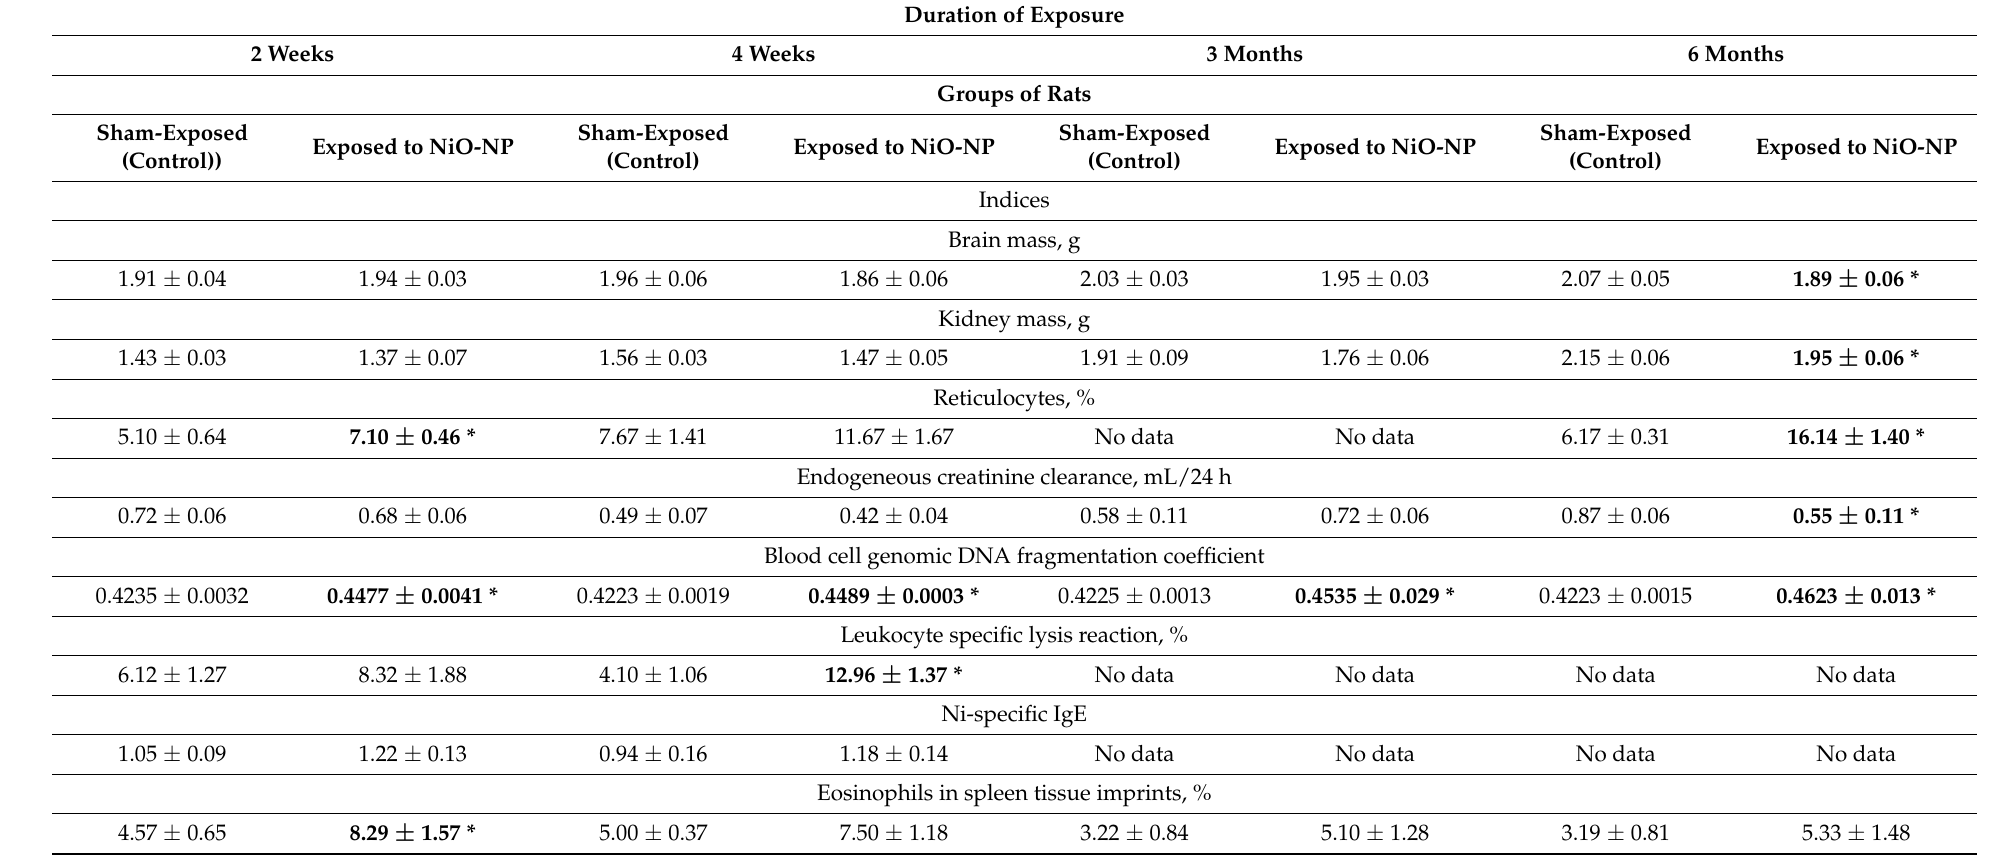
Table 3. Some indices of rat organism’s status after repeated inhalation of nickel-oxide nanoparticles ( x ± s.e.